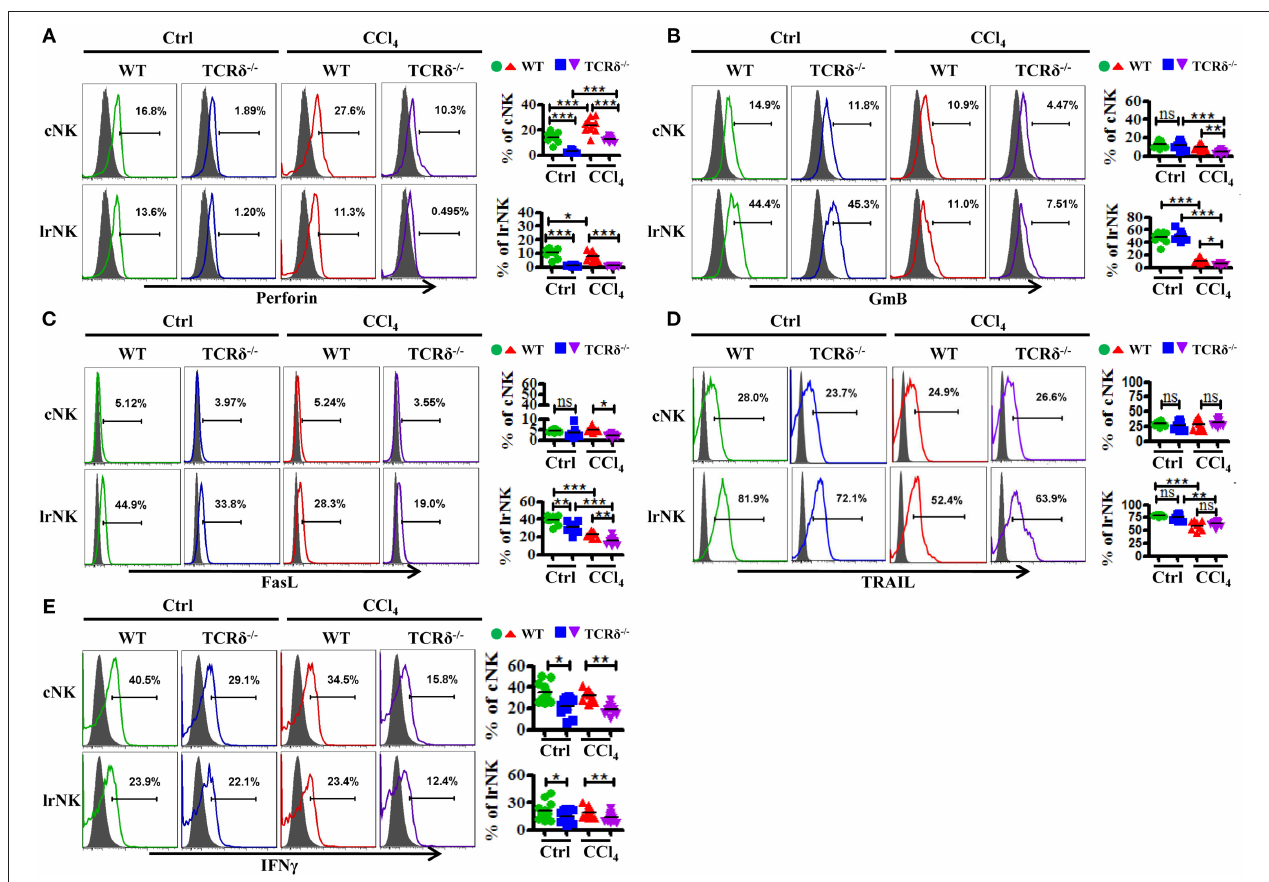
FIGURE 7 | γδ T cells deficiency impairs the expression of cytotoxic effector molecules of lrNK and cNK cells upon chronic liver injury. (A–E) Liver mononuclear cells were isolated from WT or TCR δ − / − mice with or without CCl 4 continuous administration, respectively. (Left) The expression of Perforin, GmB, FasL, TRAIL, and IFN γ on cNK cells and lrNK cells were determined by FACS. (Right) Statistical analysis is shown, n = 9–12. * P < 0.05, ** P < 0.01, *** P <